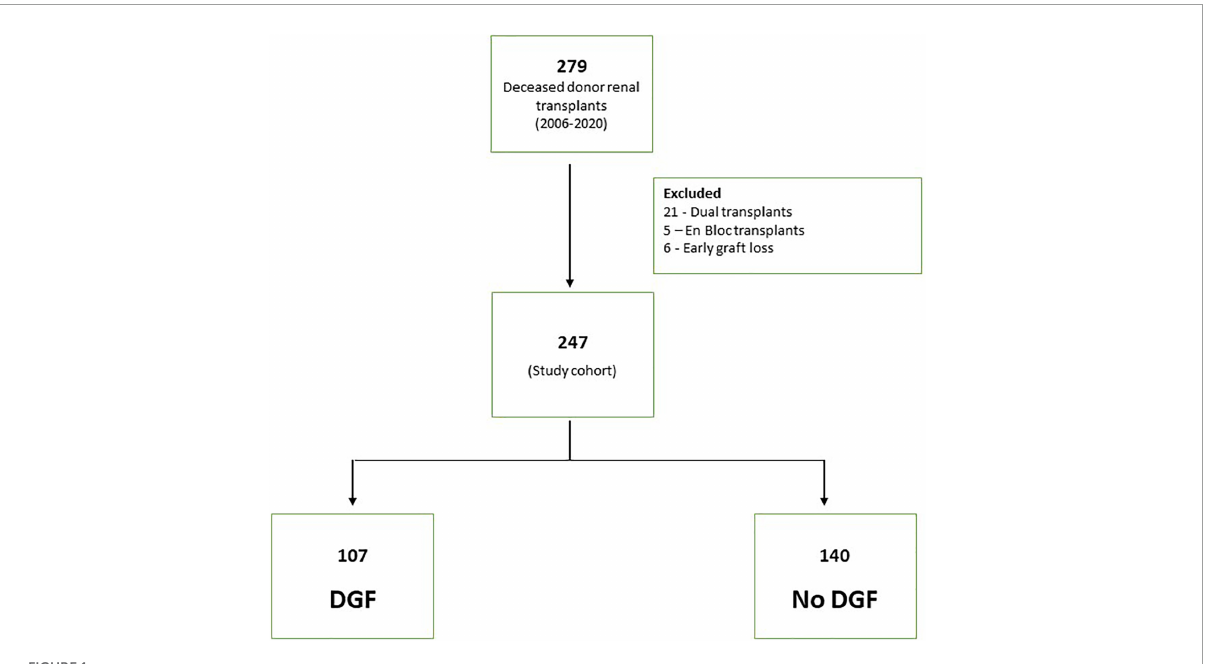
FIGURE1 Consort diagram of study